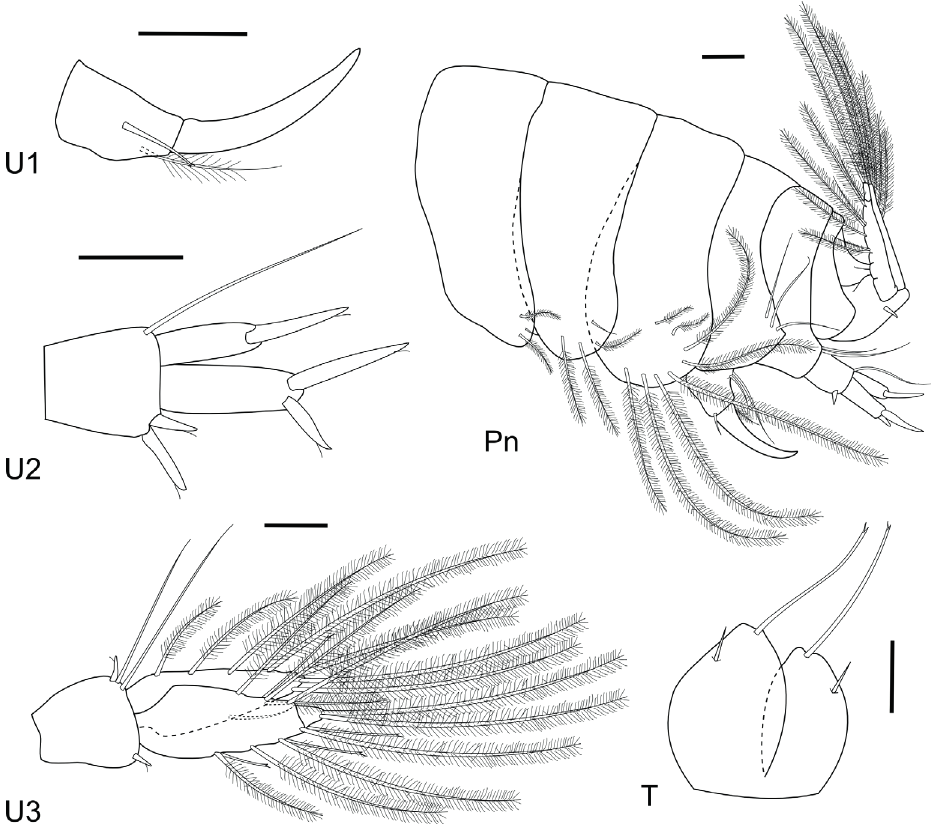
Figure 15 - Puelche mourae sp. nov. Female, 4.0 mm, MNRJ 28795: Uropods, pleon and telson. Scales = 0.1